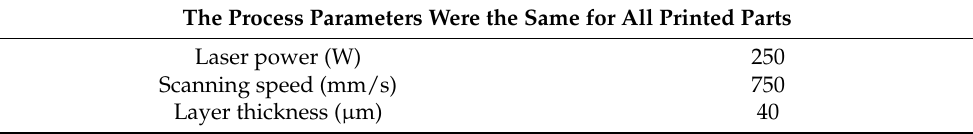
Table 3. Selective laser melting (SLM) process parameters [19].